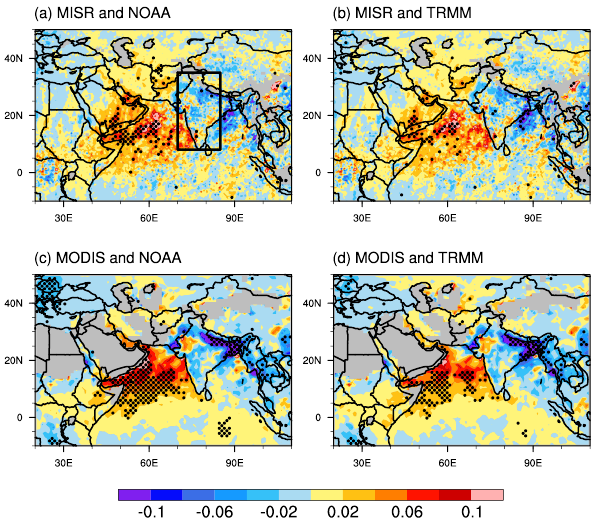
Figure 5. Same as Fig. 4, but for the spatial patterns of precipitation (mmday − 1 ) regressed on area-averaged AOD in the AS, the south AP, and the IP (box in a